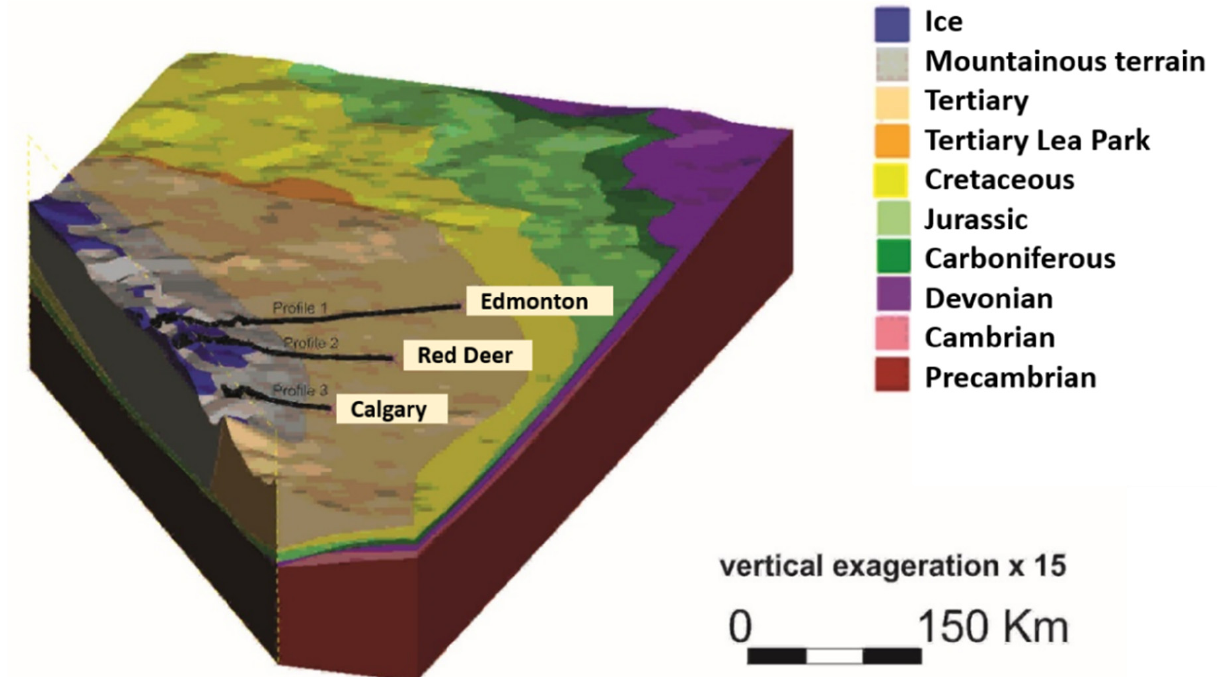
Figure 6. Three-dimensional geological model of the study area with location of the selected 2D transects.